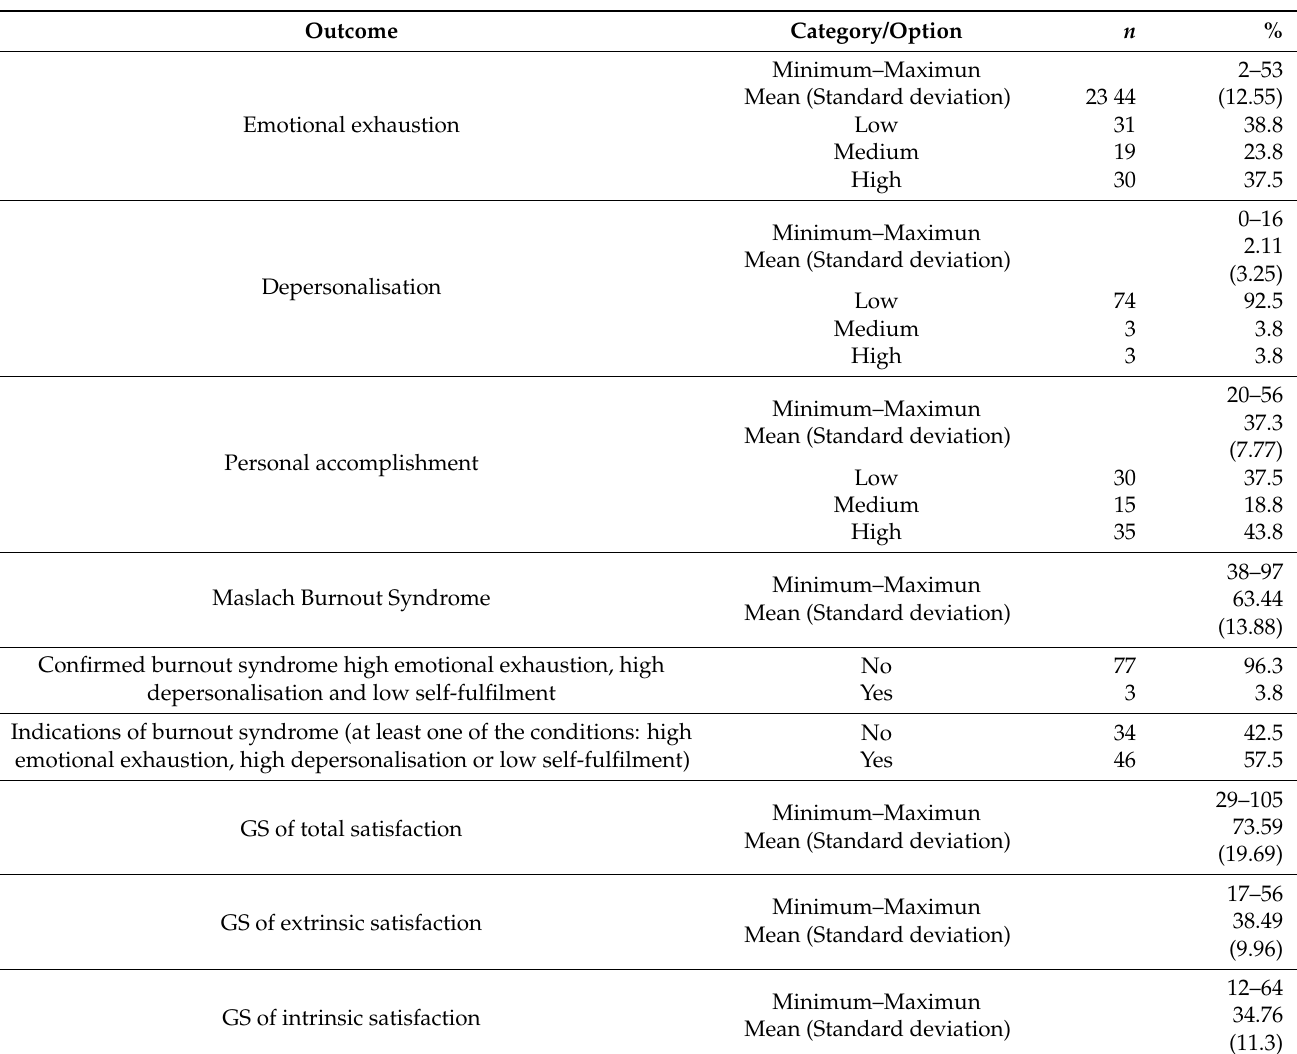
Table 2. Characteristics of the psycho-occupational health of the